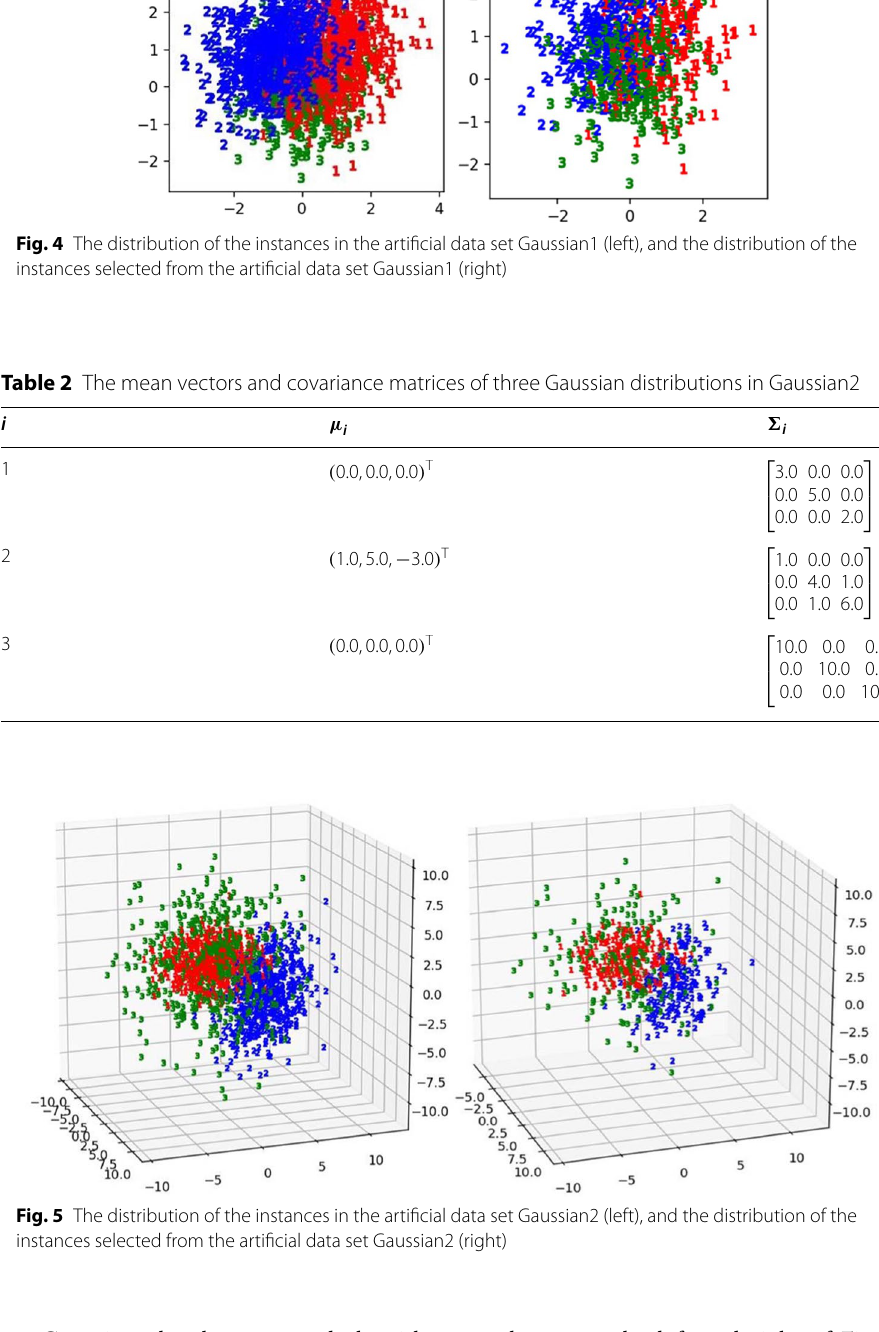
set Gaussian1 by the proposed algorithm are shown on the left and right of Fig. 4 respectively. The fourth artificial data set Gaussian2 is a three-dimensional data set with three classes followed three Gaussian distributions, it contains 1500 data points, 500 data points per class. The mean vectors and covariance matrices of the three Gaussian